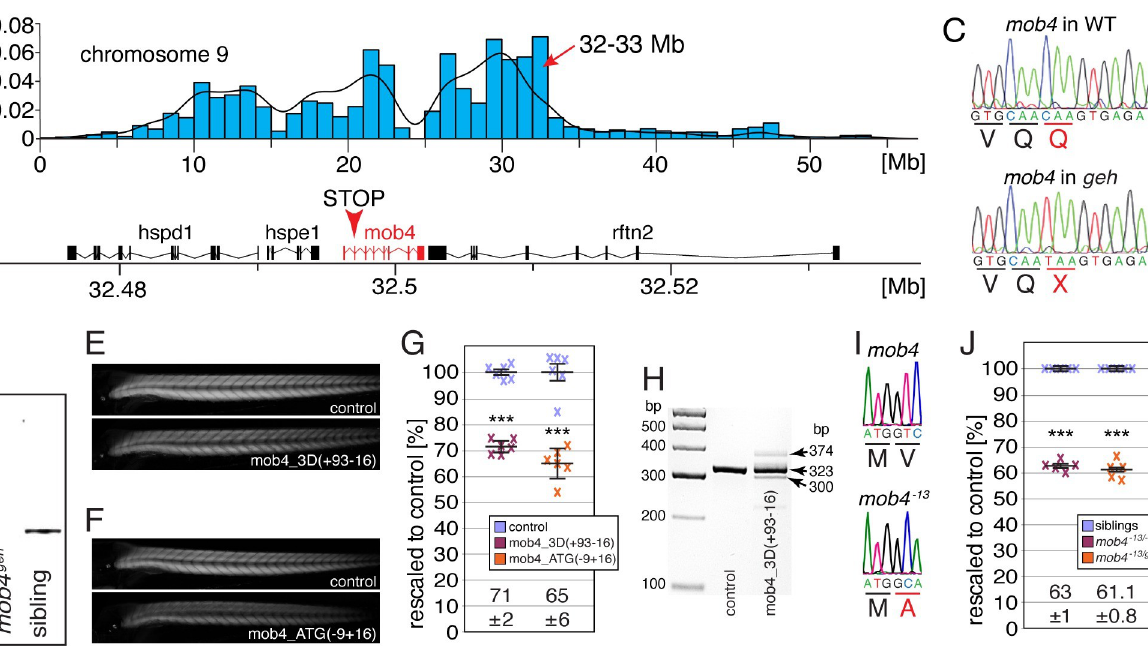
Fig 2. The function of mob4 is lost within gemütlich mutants. (A) Linkage analysis of gemütlich revealed a region of homozygosity on chromosome 9 with a peak between 32 to 33 Mb. (B) The MOB family member 4 ( mob4 ) gene was located within the linked region. (C) Genomic sequences show that the mutant gemütlich harboured a mob4 allele with a premature stop codon in exon 2 (Q41X). (D) Western blot analysis using antibodies against human MOB4 showed epitope loss in mob4 geh homozygotes. (E) Knockdown of mob4 by the morpholinos mob4_3D(+93–16) that targets the splice donor of exon 3 or (F) mob4_ATG(-9+16) that targets the translation start codon led to a reduction in birefringence. (G) Compared to control injected 3-dpf-old larvae (100 ± 1% and 100 ± 2%, respectively), administration of mob4_3D(+93–16) induced a reduction in birefringence to 71 ± 2% and mob4_ATG(-9+16) to 65 ± 6%. Crosses represent individual larvae (n = 6). (H) RT-PCR using primers targeting exons 1 and 5 of mob4 revealed altered splicing in mob4_3D (+93–16)-injected larvae. (I) The mob4 -13 allele harboured a genomic deletion of 13 bp from exon 1 (g.5_17del). (J) Compared to 3-dpf-old siblings (both 100 ± 1%), the birefringence of mob4 -13 homozygotes and mob4 -13/geh compound heterozygotes was significantly reduced to 63 ± 1% and 61.1 ± 0.8%, respectively. Crosses represent averaged birefringence of clutches with a minimum of 6 larvae per genotype (n = 5 clutches). Data are presented as mean ± SEM; ��� P < 0.001 calculated by Student’s